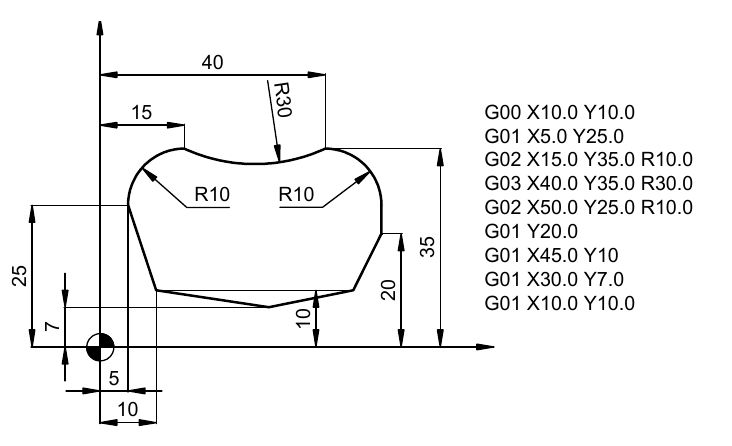
Figure 4. Example of contour feature declaration.